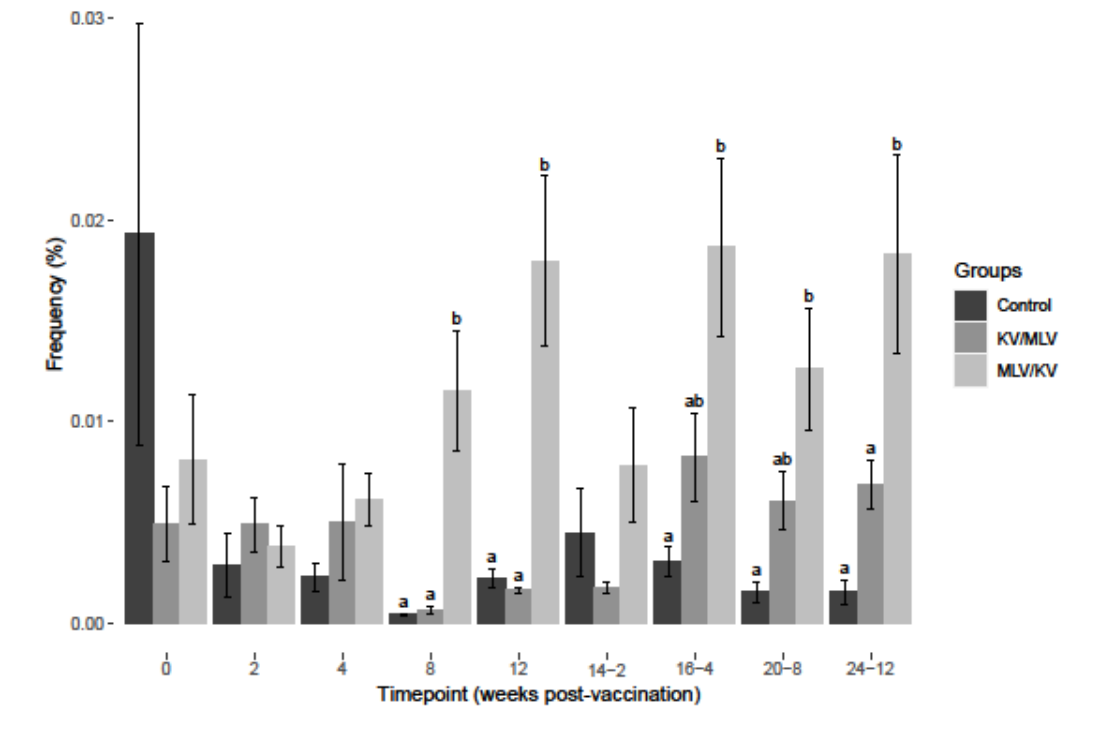
Figure 4. Frequency of IFN- γ mRNA -positive CD8 + cells after 24-hour stimulation at each respective timepoint over the course of the study with (a) BVDV-1a (PI-34) and (b) BVDV-2a (PI-28). Values at each timepoint, not connected by the same letter are significantly different ( p < 0.05).